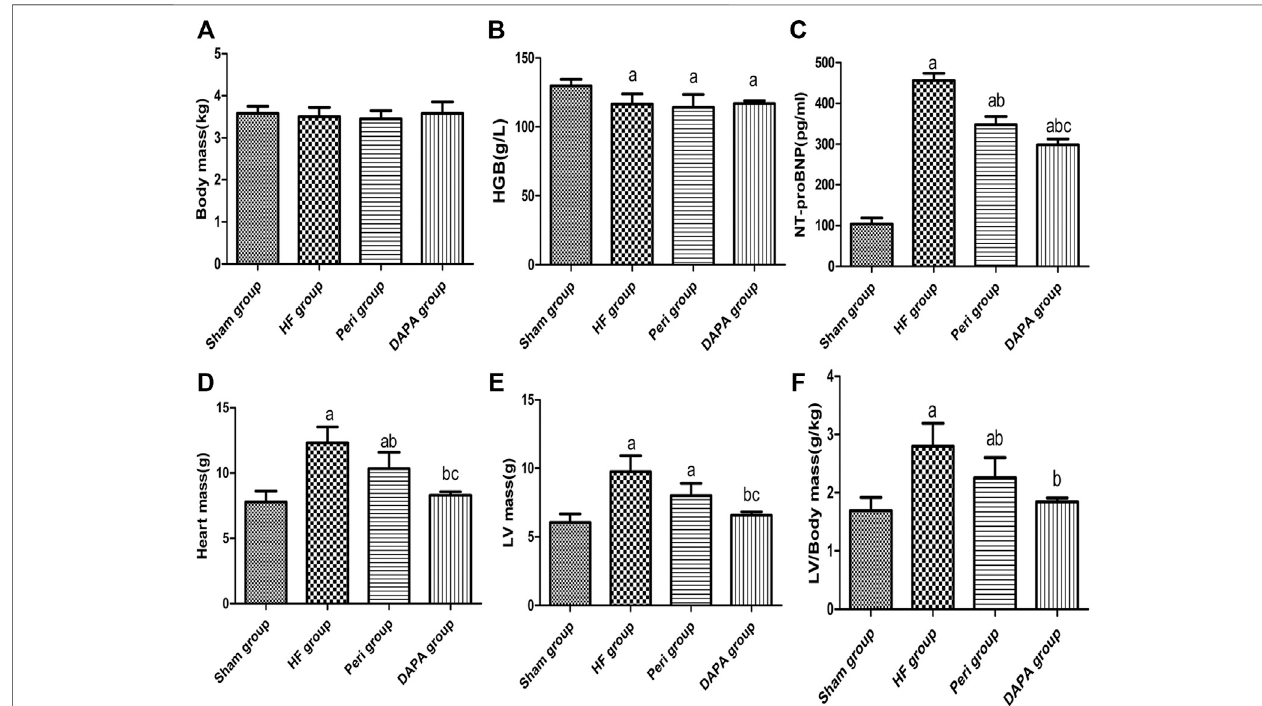
FIGURE 1 | Characteristics and biochemical indicators with statistical differences after 10 weeks of treatment in four groups. a p < 0.05 vs. the sham group; b p < 0.05 vs. the HF group; c p < 0.05 vs. the Peri group.